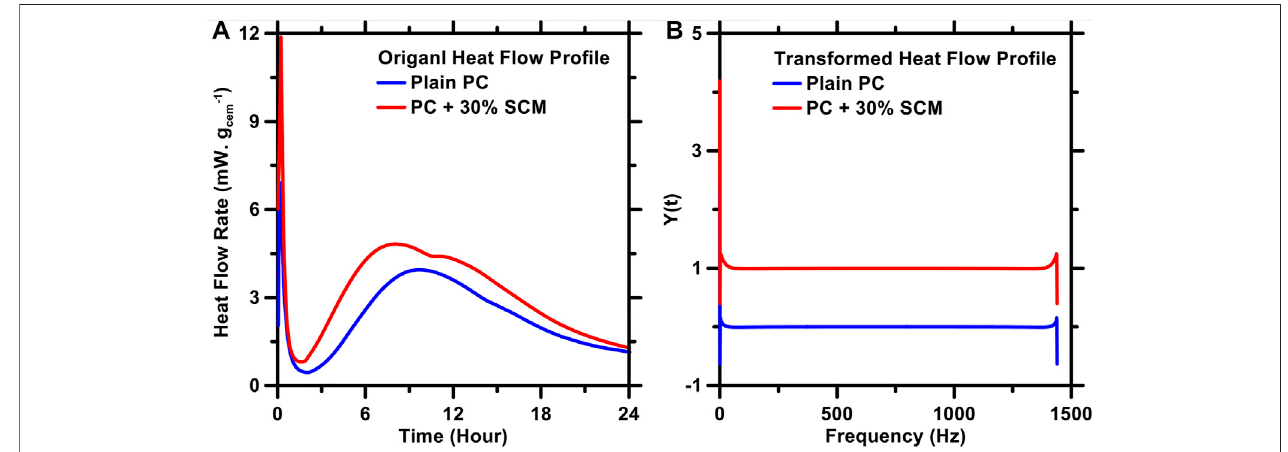
FIGURE 3 | (A) Original and (B) FFT-transformed heat fl ow rate pro fi les of representative plain and (PC + SCM) pastes. As can be seen, FFT transformation signi fi cantlyreducesthedimensionality(complexity)ofthepro fi le;therebymakingiseasierandmore(computationally)ef fi cientfortheFT-DLmodeltostatisticallyanalyze the datasets – and learn input-output correlations – during its